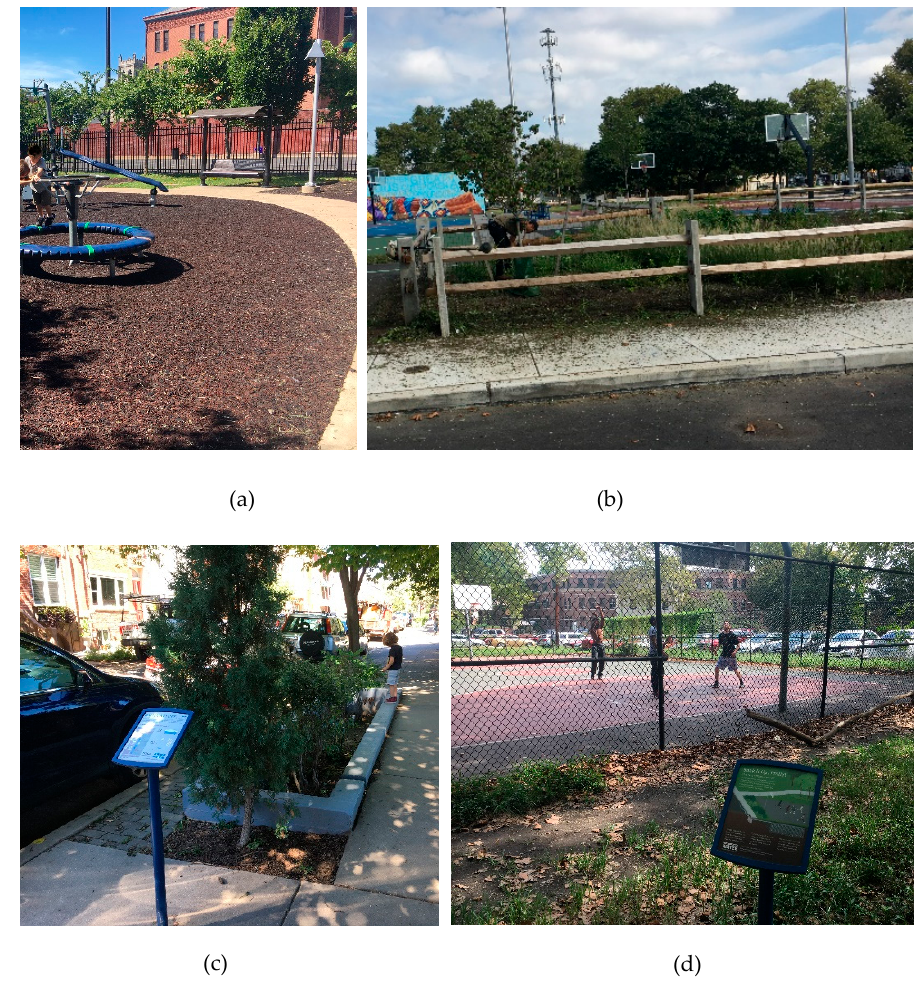
Figure 5. Four examples of public interaction with GSI projects. ( a ) a children’s playground with pervious surface; ( b ) a person maintaining a rain garden; ( c ) a child exploring a rain garden; ( d ) young adults paying in a basketball court, which is an infiltration trench. Photos by Shane